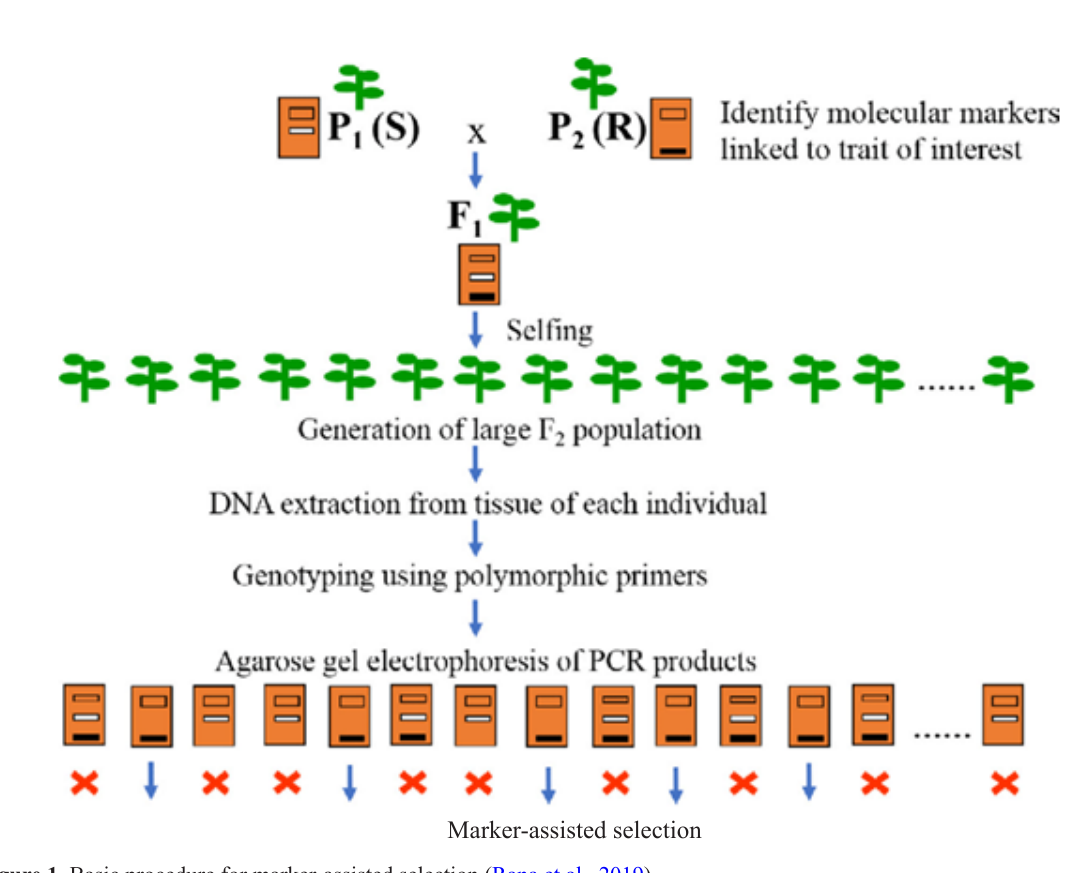
Figure 1. Basic procedure for marker-assisted selection (Rana et al.,